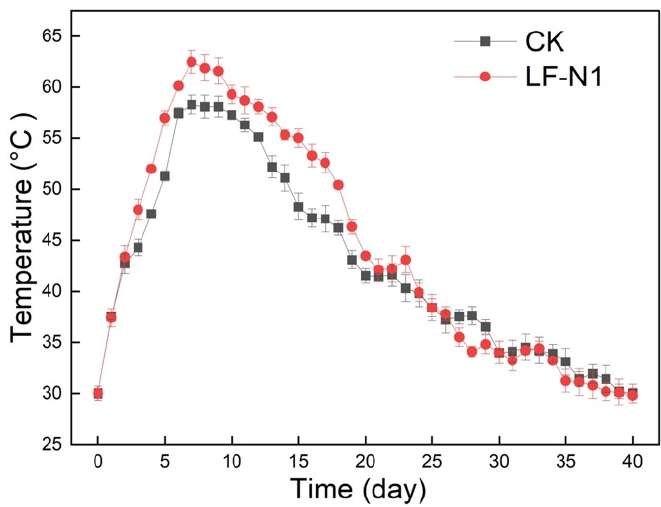
Figure 1. The temperature profile throughout composting.